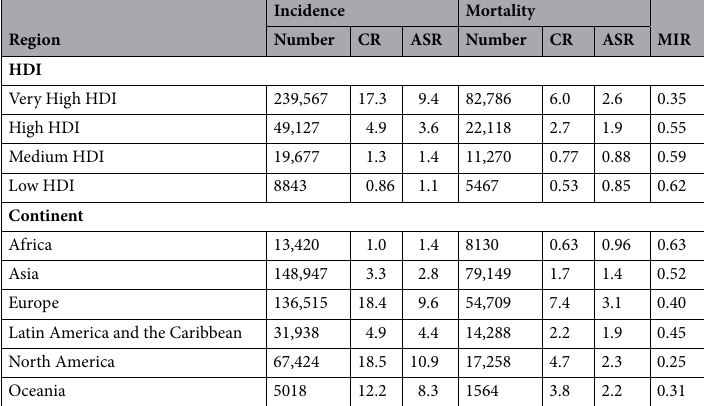
Table 1. Summary of the KC incidence, mortality, and MIR according to